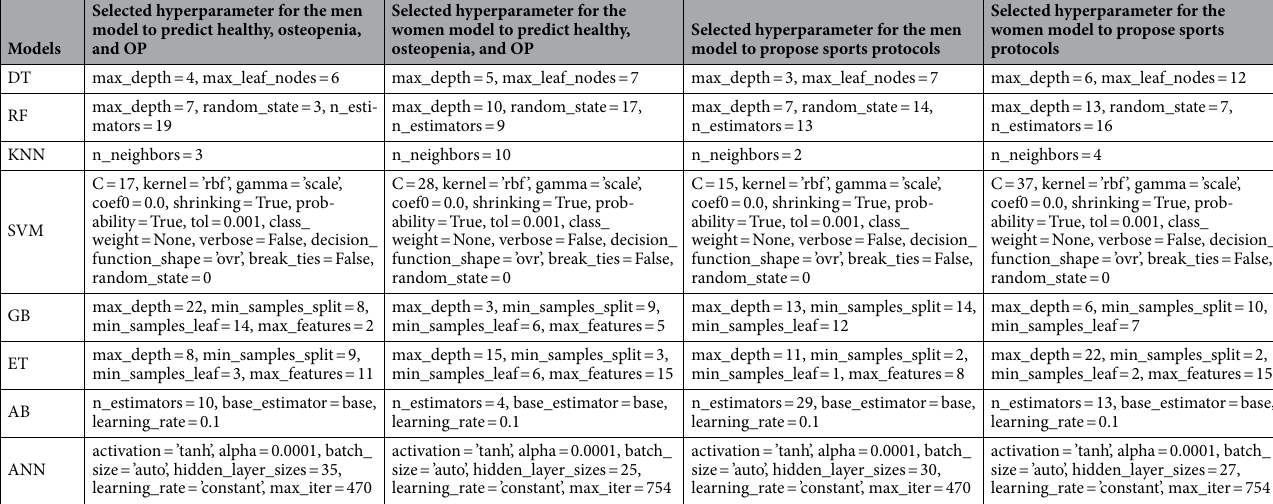
Table 2. Selection of hyperparameters for the DT, RF, KNN, SVM, GB, ET, AB and ANN